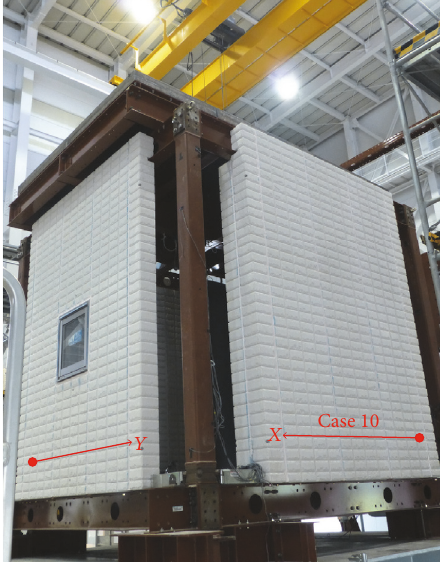
Figure 5: External views of Case 6 and Case 8 .